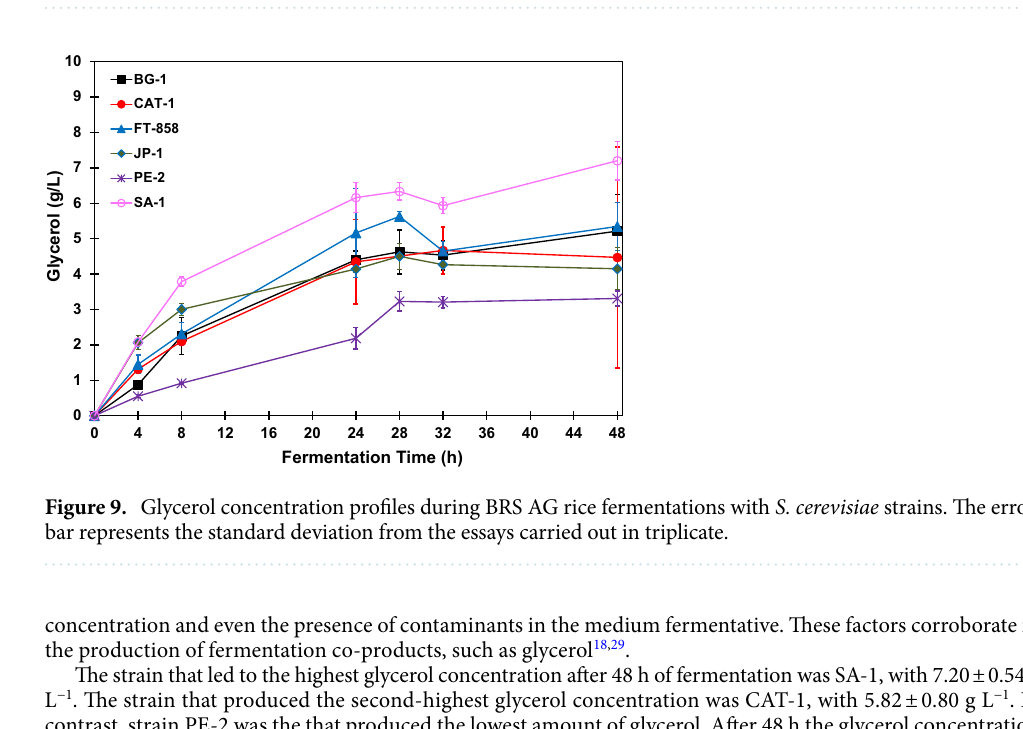
Figure 8. Ethanol concentration profiles during BRS AG rice fermentations with S. cerevisiae strains. The error bar represents the standard deviation from the essays carried out in triplicate.